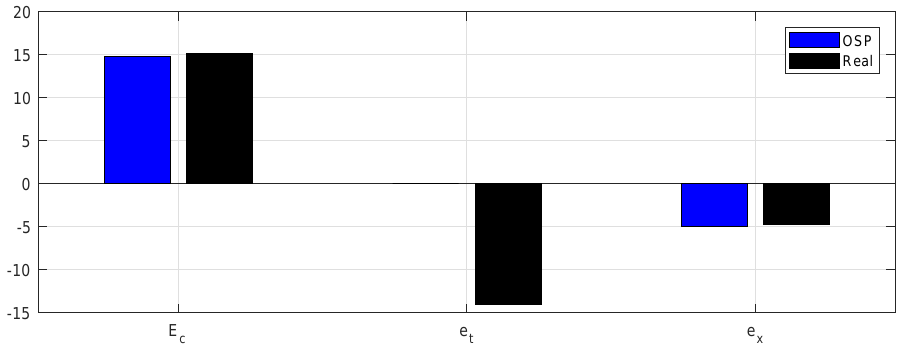
Figure 17. Case D—Real (black) and simulated (blue) energies (kWh), traveling times (s) and distance errors (m).